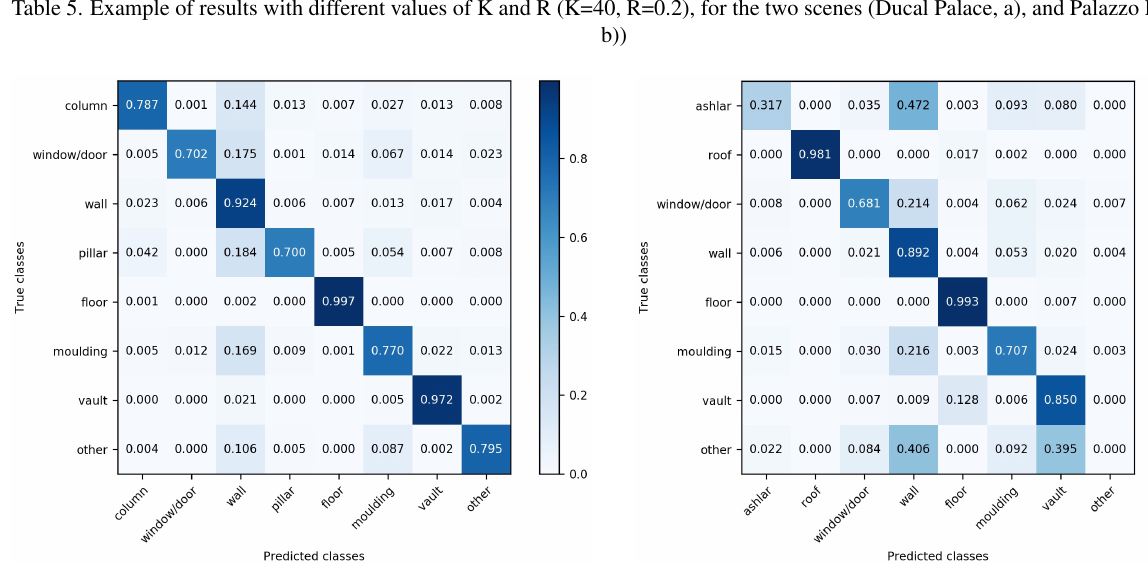
Figure 6. Confusion matrix of the combined approach on the PF